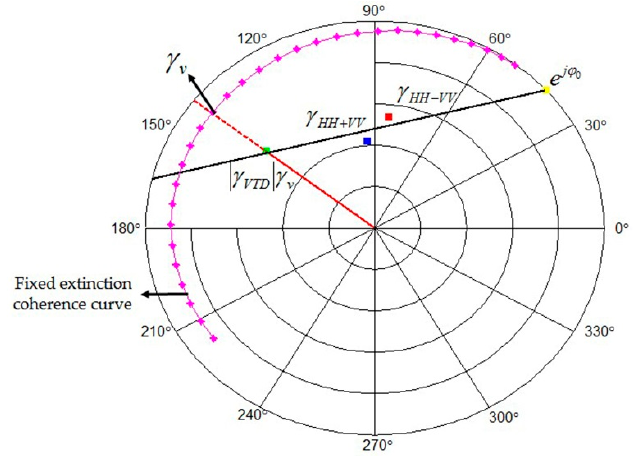
Figure 13. Geometrical representation of the volume height and volume temporal decorrelation estimation in the four-stage algorithm.